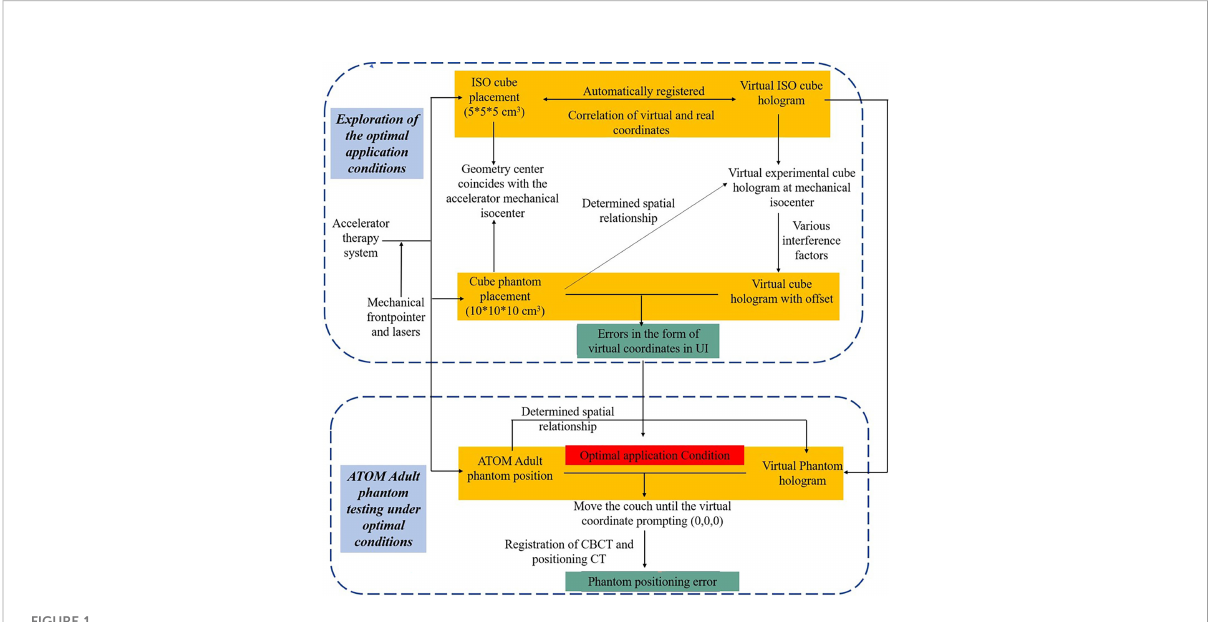
FIGURE 1 The overall experimental for the proposed AR-assisted positioning